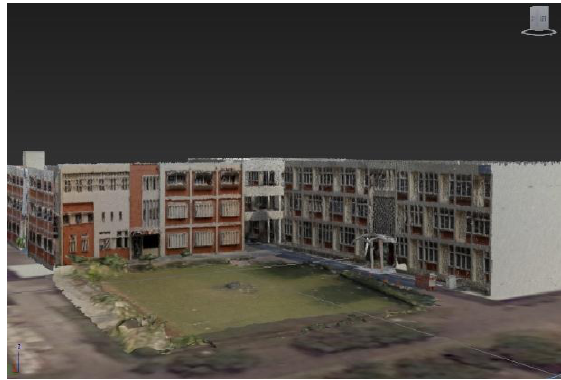
Figure 18: 3D model of civil engineering department